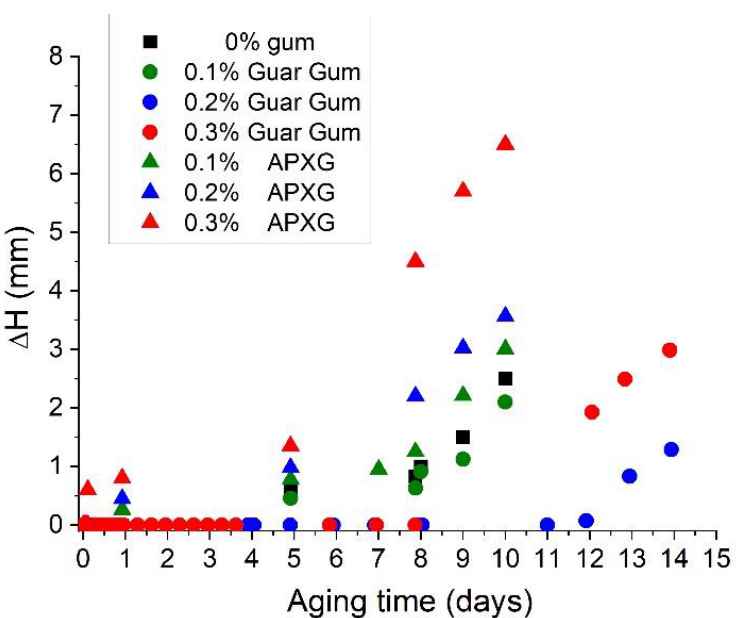
Figure 4. Height of the serum layer with aging time for linseed oil emulsions as a function of gum type and gum concentration.